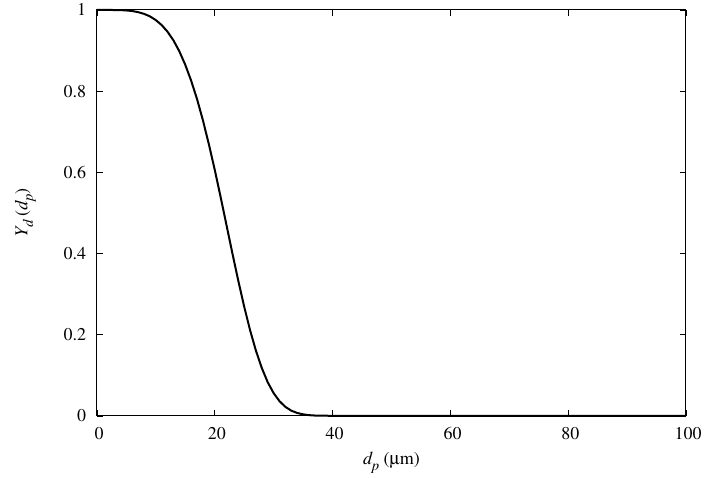
Figure 12. Complimentary Rosin–Rammler distribution function (Equation (8)) with d = 23.48 µ m and n = 4.32. These values were determined after analysis of the fog generated in experiments performed in our laboratory.